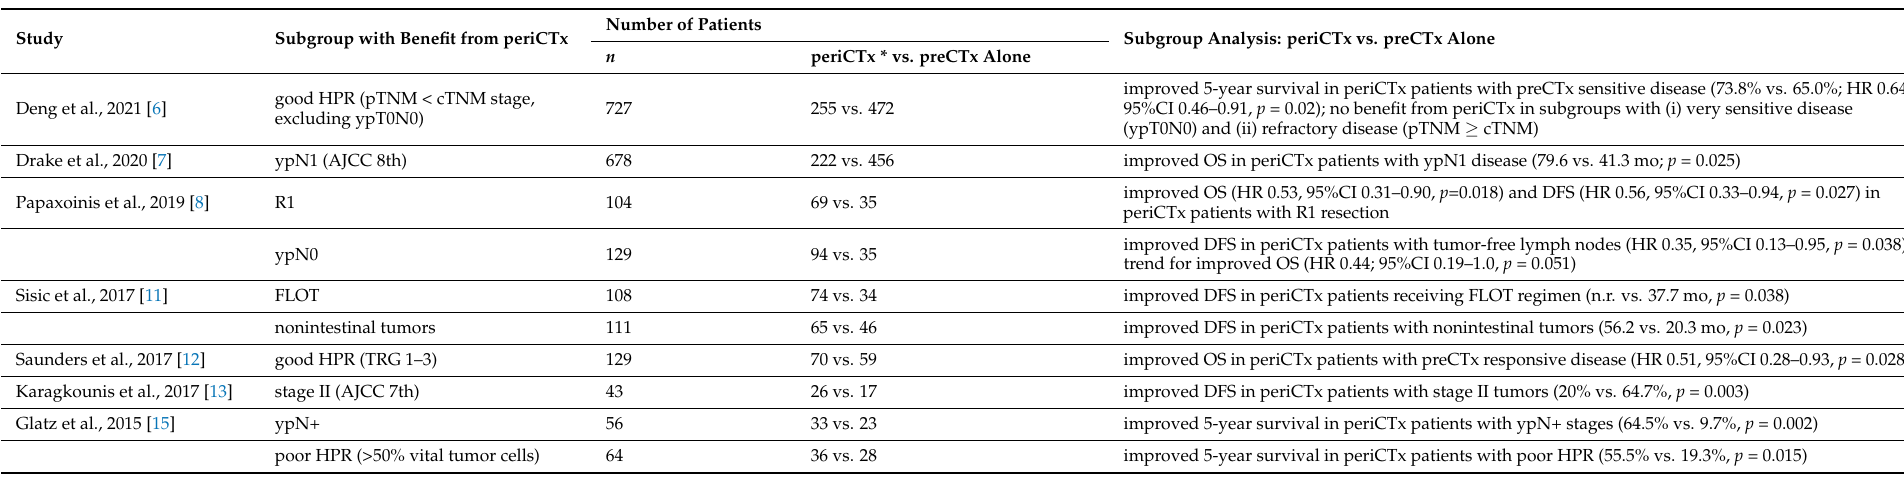
Table 3. Identified subgroups with benefits from perioperative chemotherapy in retrospective